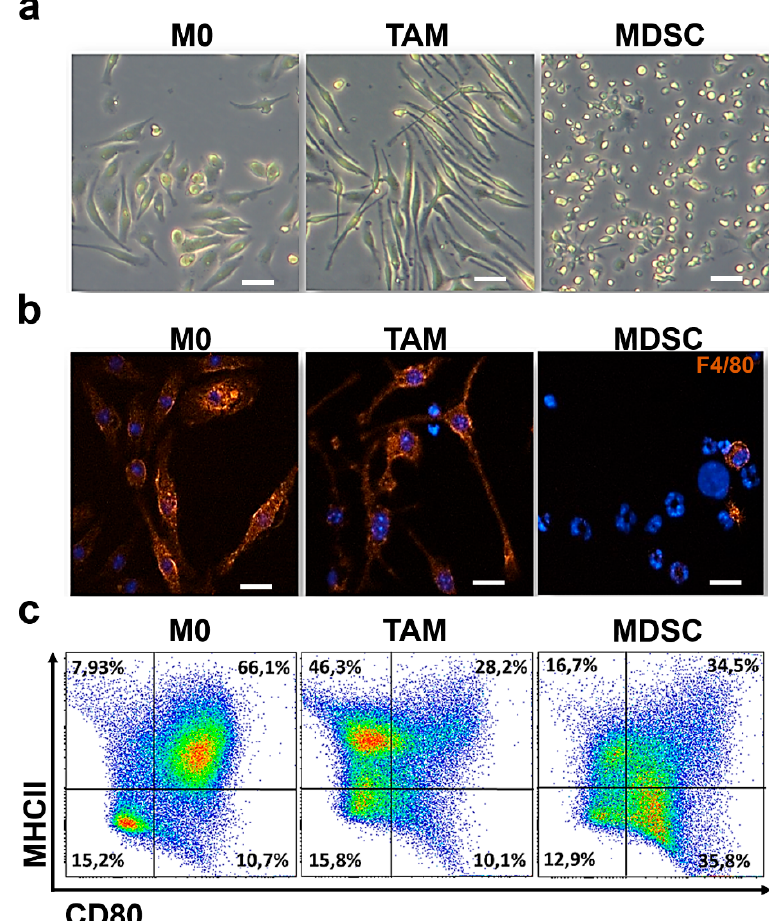
Figure 1. Phenotype of bone marrow-derived non-polarized macrophages, TAM-like macrophages and MDSC. ( a ) Phase contrast micrographs of cultures of ex vivo-differentiated uncommitted macrophages (M0), TAMs and MDSCs as indicated. Bars represent, 100 µm. ( b ) Fluorescence microscopy pictures of immunocytochemistry staining of the macrophage-specific marker F4/80 (orange) and nuclei stained with Hoesch (Blue). Macrophage and TAM preparations highly expressed F4/80, while MDSCs show typical multilobed or annular nuclei. Bars represent 100 µm. ( c ) Flow cytometry density plots of MHCII and CD80 expression in uncommitted macrophages (M0), TAMs and MDSCs as indicated. The gates were established according to unstained control cells. Percentage of events within each gate are indicated in the graphs.